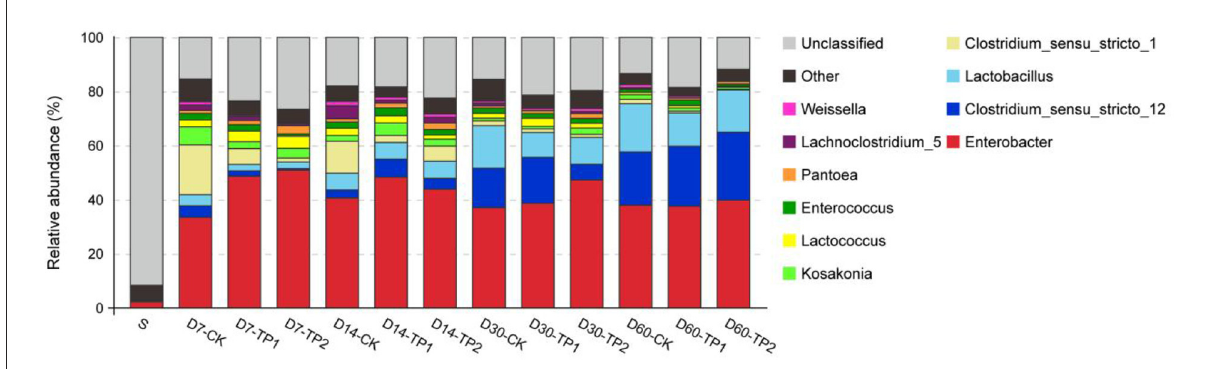
FIGURE3 Relative abundance of bacterial community on genus level of stylo silage ensiled with addition of tea polyphenols (S: raw stylo; D7-CK: on day 7 of ensiling fermentation-blank control, silage ensiled without addition of tea polyphenols; TP1 and TP2: silage ensiled with addition of 0.2%, 0.4% tea polyphenols on a FM